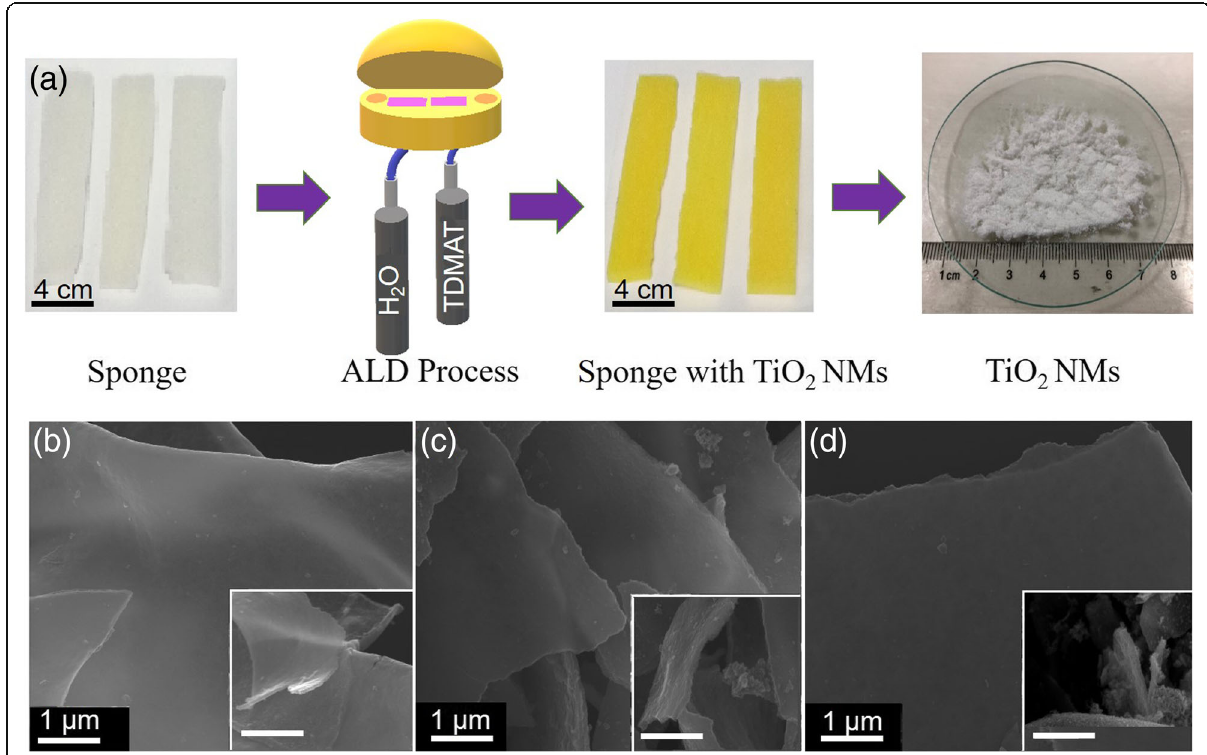
Fig. 1 Fabrication process and morphologies of TiO 2 NMs with different thicknesses. a Sketch represented fabrication process of TiO 2 NMs. b – d SEM images of TiO 2 NMs with 100, 200, and 400 ALD cycles, respectively. Scale bars in insets are 1 μ